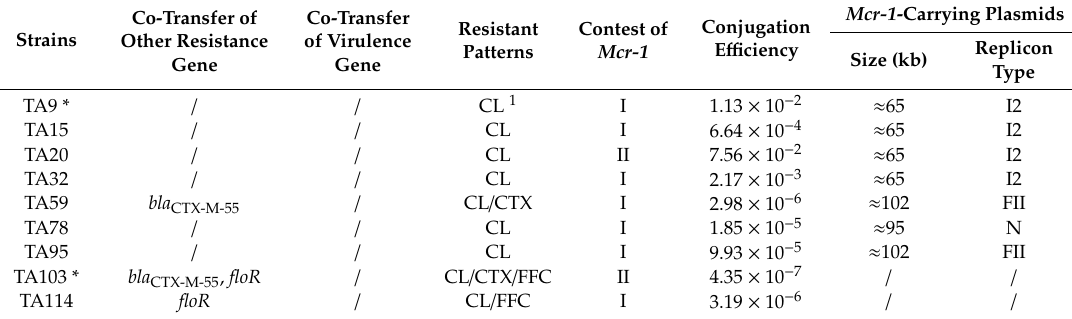
Table 3. Characterization of some plasmids carrying mcr-1 of